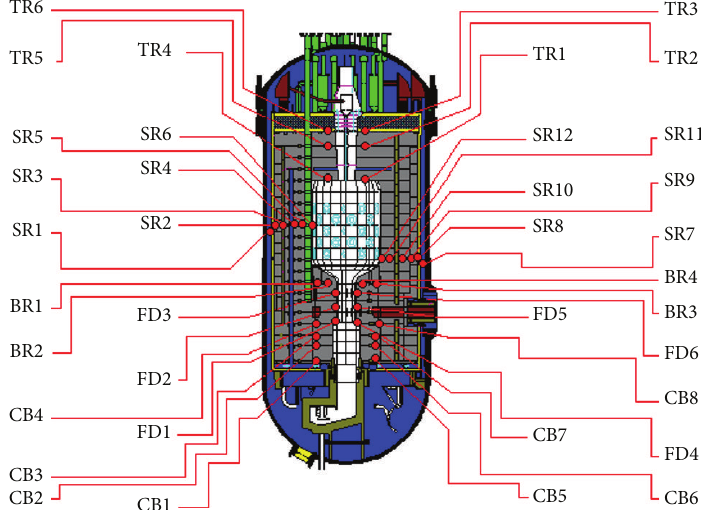
Figure 4: Thermocouples in the reactor internals.